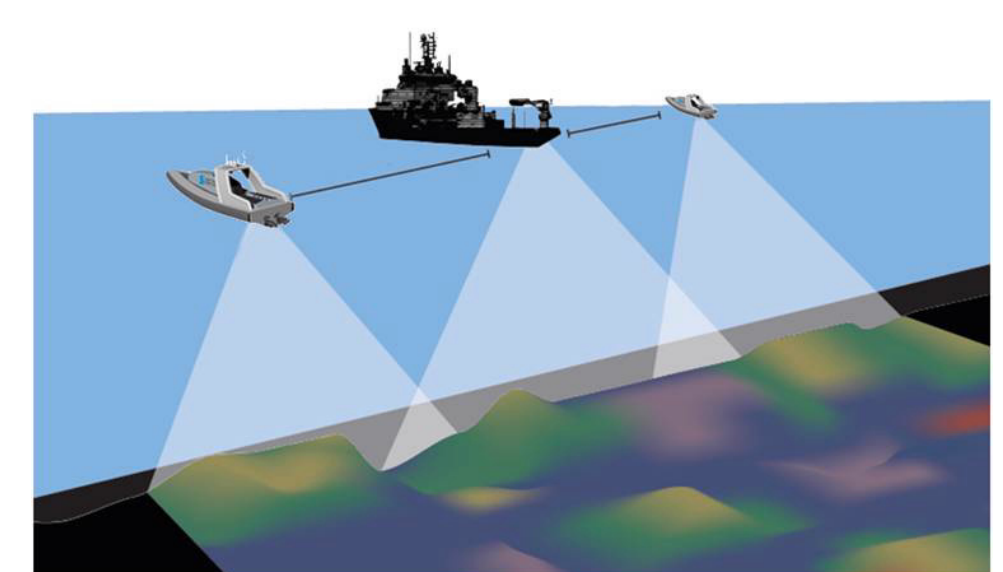
Figure 19: USV-assisted seabed mapping entails faster and cheaper operations since the capacity of the main survey vessel is augmented by that of a fl eet of USVs. Courtesy of Maritime